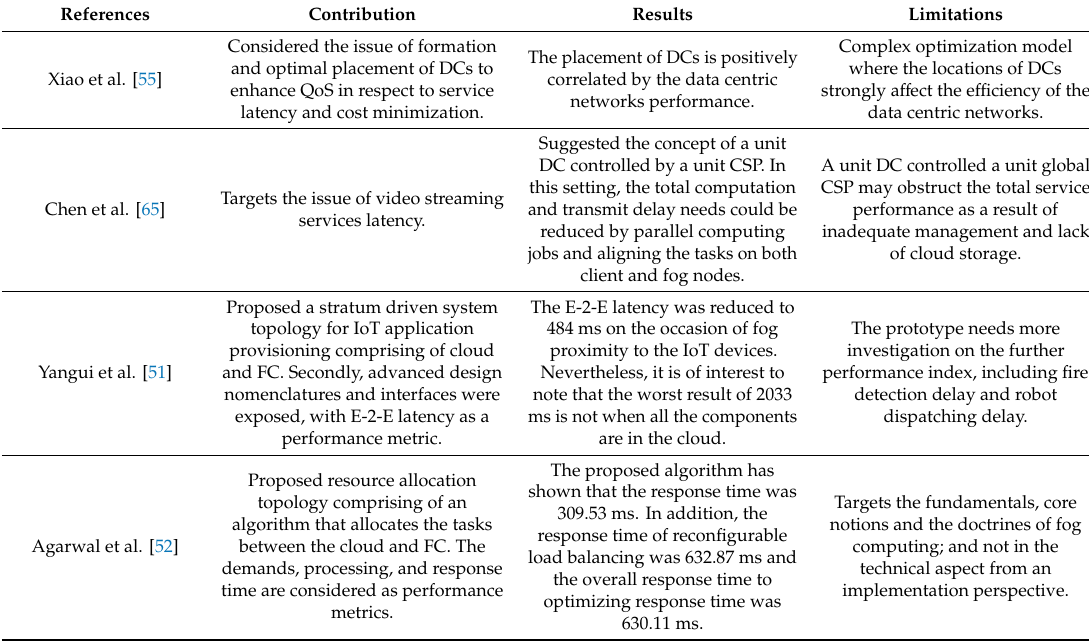
Table 3. Summary of the state-of-the-art for 5G computing